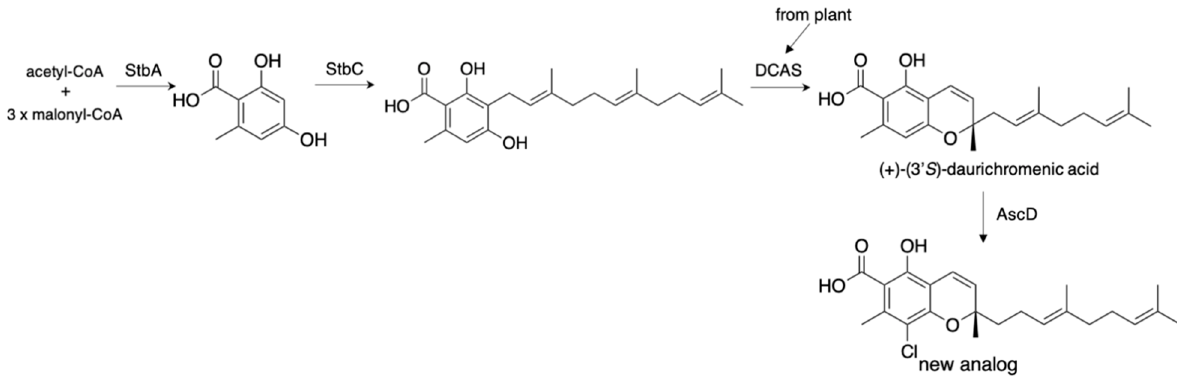
Figure 9. Production of plant meroterpenoids in A. oryzae.